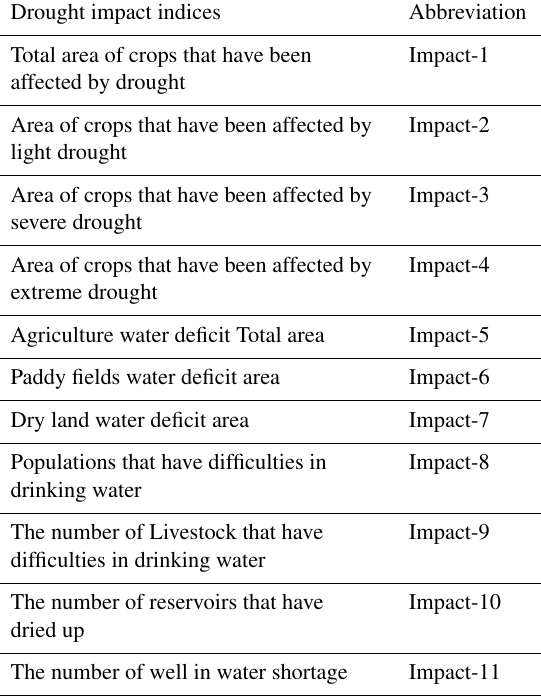
Table 1. Drought impact indices and their